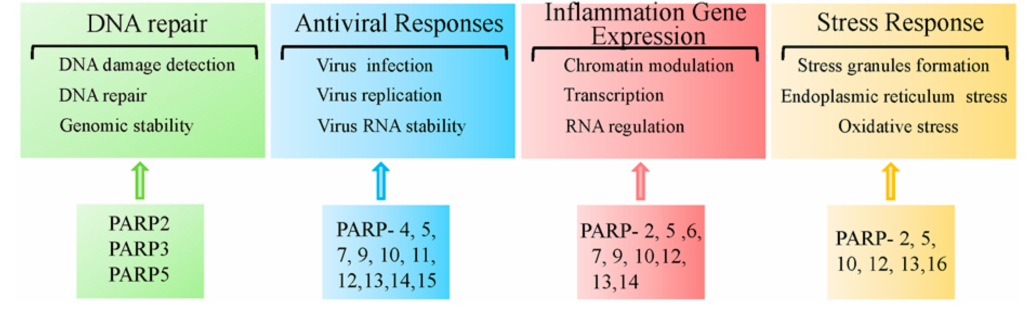
Figure 7. Other PARP functions in human